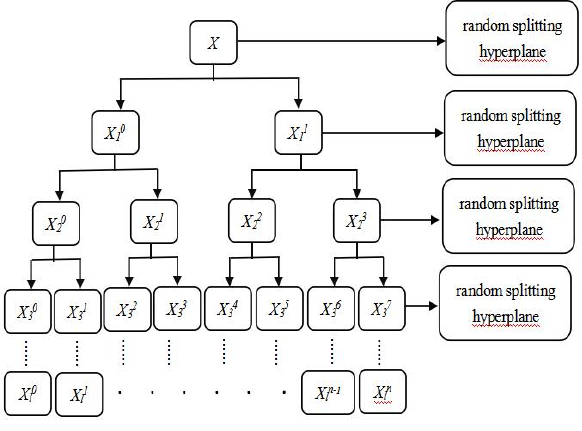
Figure 1. The k-d tree procedure